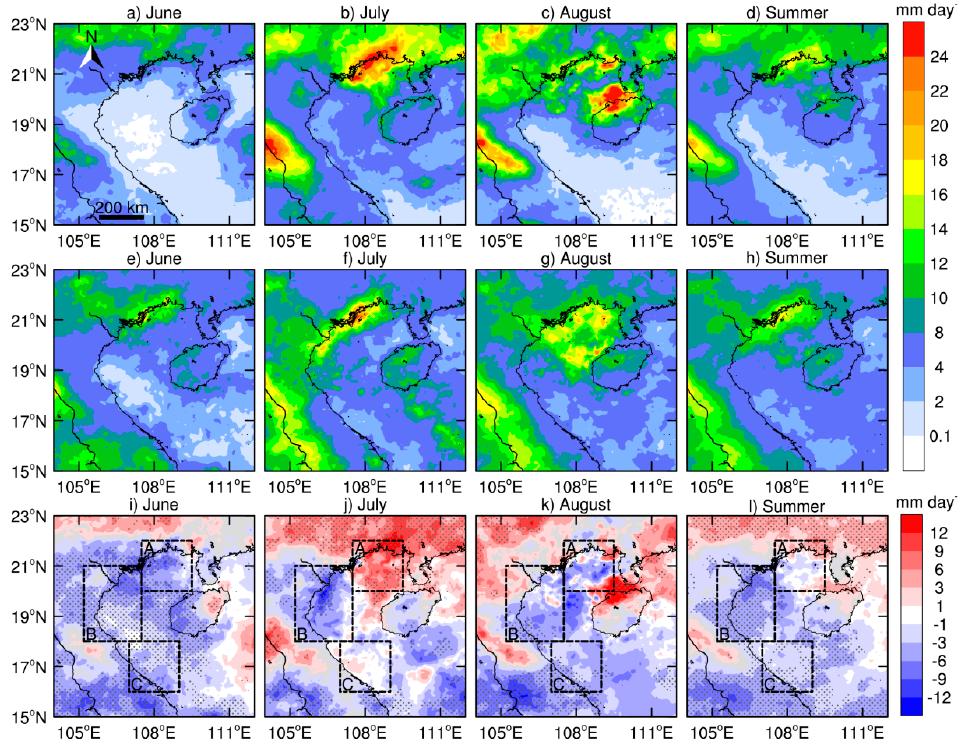
Figure 8. Same as Figure 4 but for rainfall.